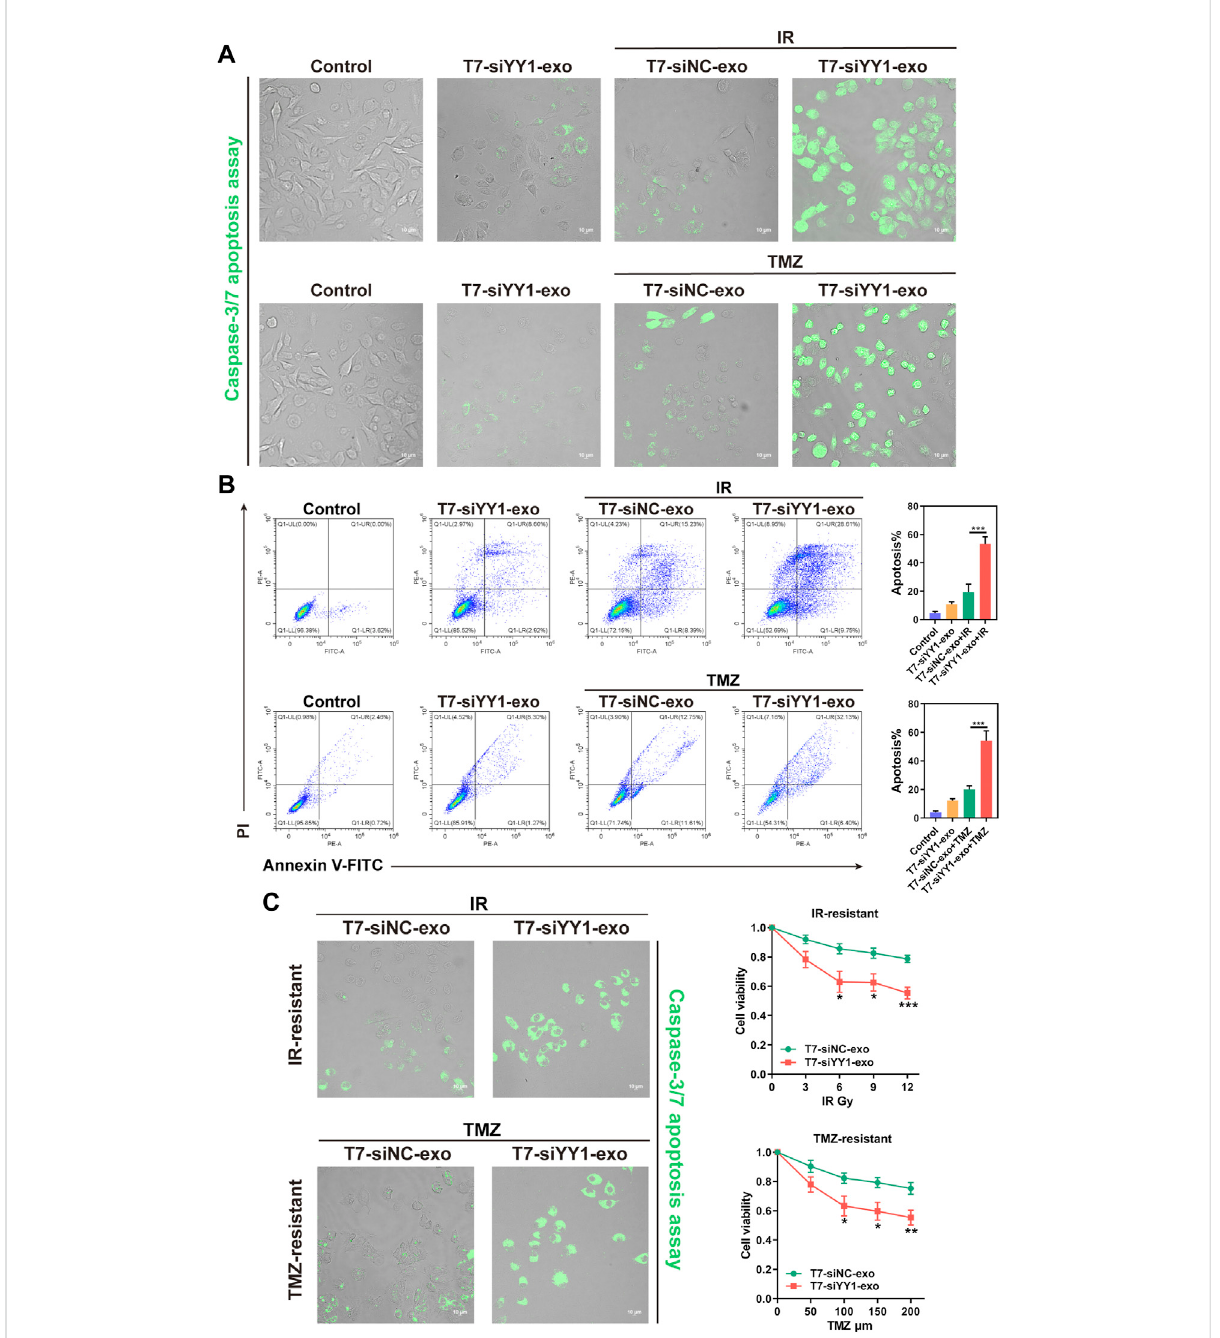
FIGURE 3 The therapeutic effect of T7-siYY1-exo in vitro. (A) LN229 cells were cultured in thepresence of T7-siNC-exo/T7-siYY1-exo (5 μ g/ml) and TMZ (50 μ M)/IR (6Gy) for2 days andapoptoticcells werevisualizedbycaspase-3/7apoptosisassay. The fl uorescentwas photographedunderaconfocal laser scanning microscope using Nikon NIS-Elements software (Nikon, Tokyo, Japan). Data in a are representative of three independent biological experiments. (B) LN229 cells administrated with T7-siNC-exo/T7-siYY1-exo (5 μ g/ml) and TMZ (50 μ M)/IR (6Gy) were subjected to FACS